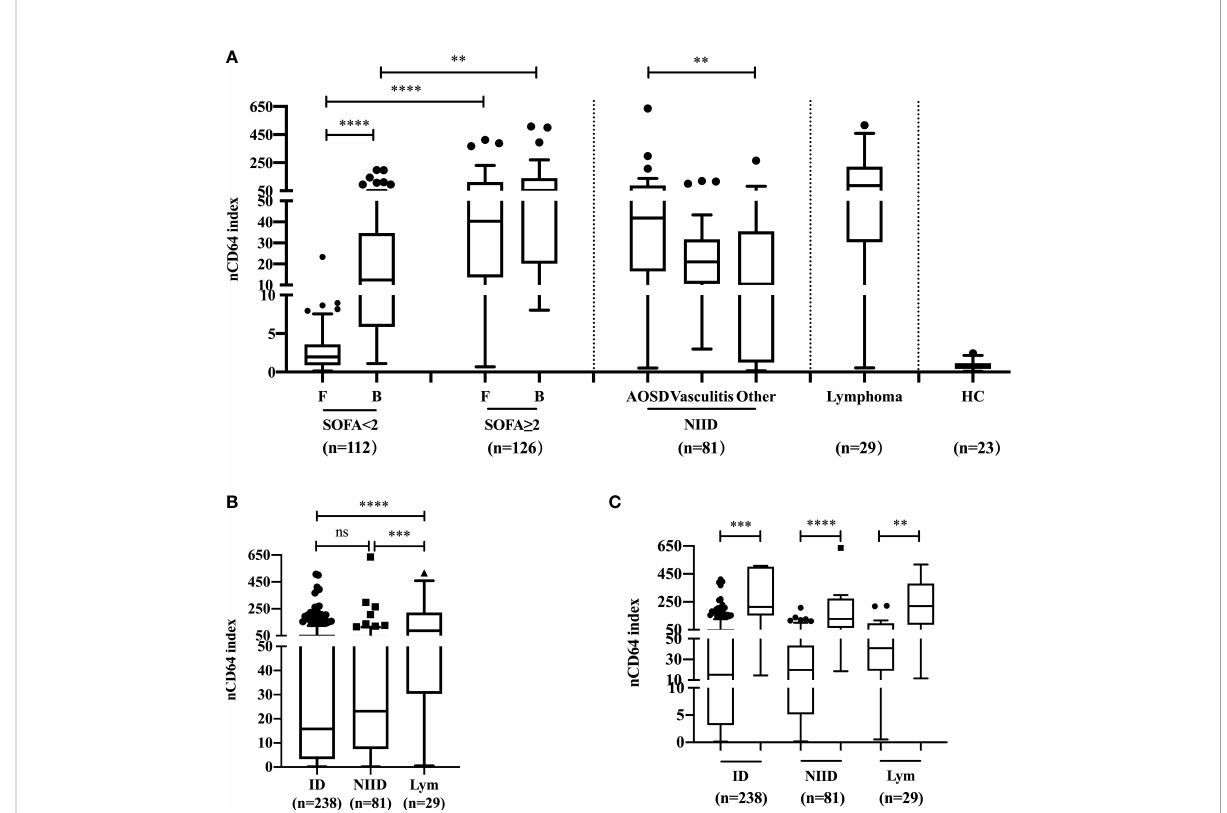
FIGURE 2 The pro fi le and comparison of nCD64 index among patients with febrile diseases. (A) The investigation of nCD64 index in febrile patients and HC. (B) The difference of nCD64 index among ID, NIID and lymphoma. (C) The pro fi le of nCD64 index during hemophagocytic lymphohistocytosis induced by various etiologies, the circle (left) represents the patients with hemophagocytic lymphohistocytosis and the square (right) represents those without hemophagocytic lymphohistocytosis. The data is presented as median with interquartile range (IQR). The comparisons of nCD64 index between independent groups were performed using Mann-Whitney U test (two groups), and Kruskal-Wallis test (multiple groups) followed by Dunn ’ s post-test for multiple comparisons. ** P <0.01, *** P <0.001, **** P <0.0001. nCD64, neutrophil CD64; F, focal infection; B, bloodstream infection; SOFA, Sequential Organ Failure Assessment; AOSD, adult-onset Still ’ s disease; HC, healthy controls; ID, infectious diseases; NIID, non-infectious in fl ammatory diseases; Lym, lymphoma; IQR, interquartile range; ns, no signi fi